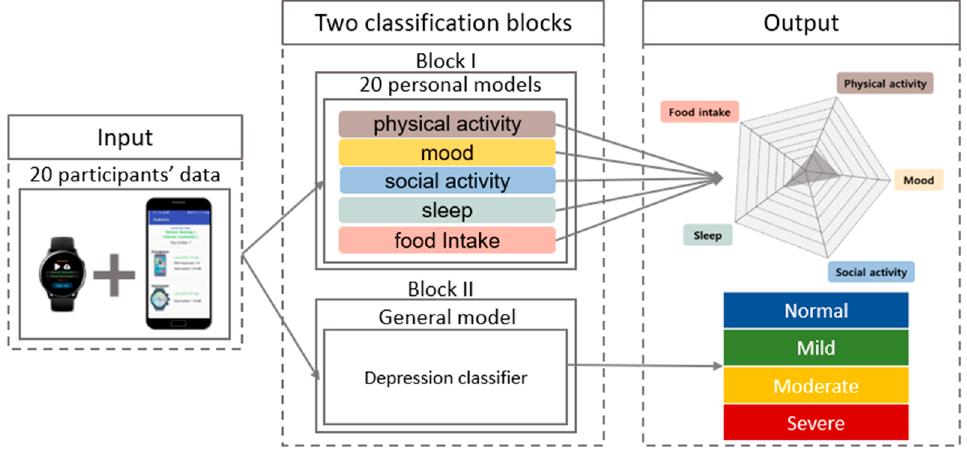
Figure 6. Flow diagram of depression group classification approach.